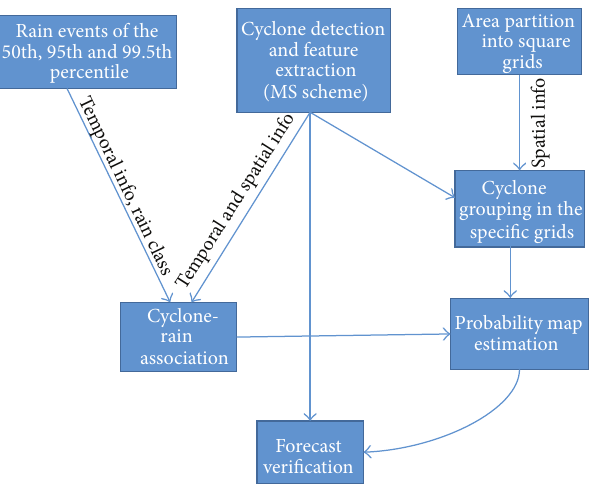
Figure 1: Analysis procedure